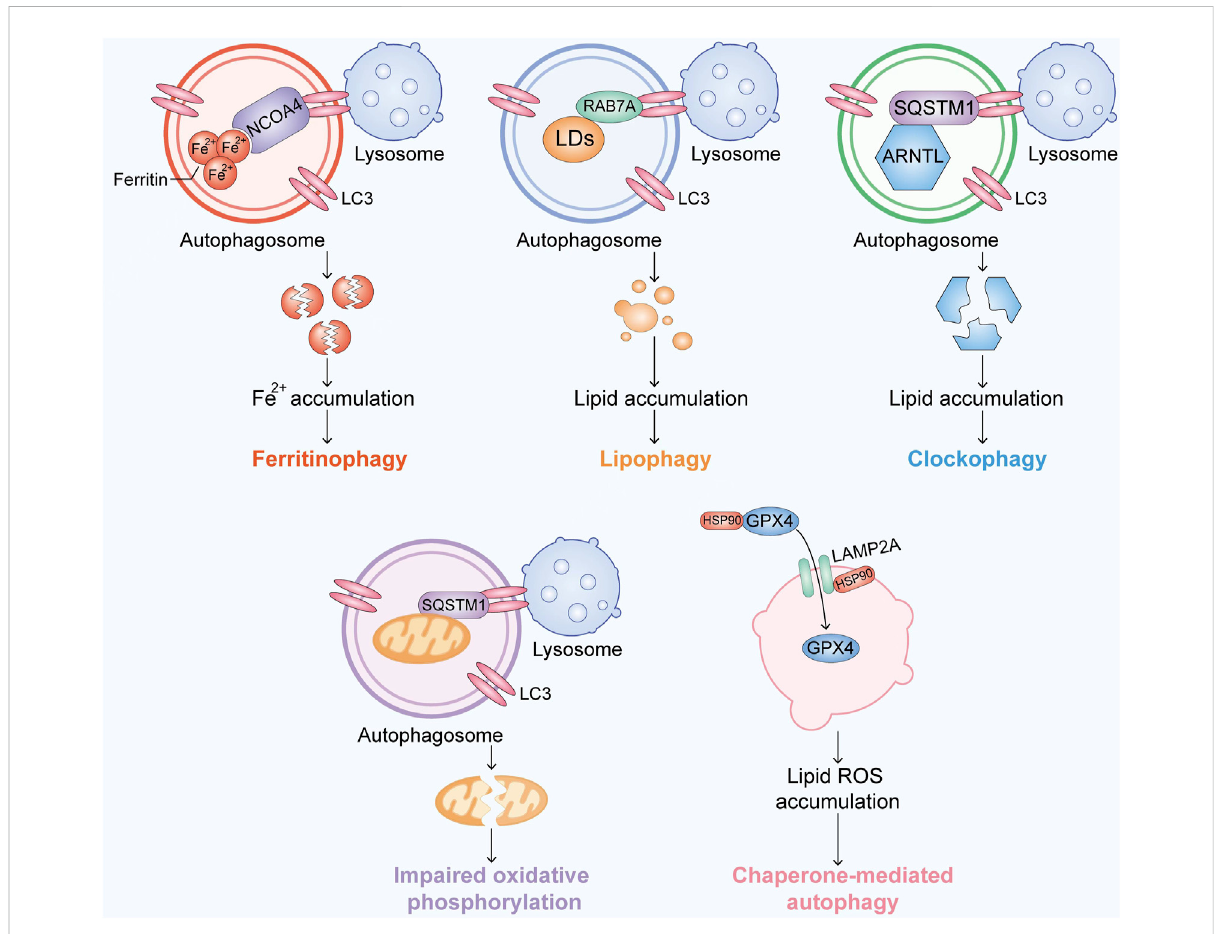
FIGURE 2 Overview of the recent research progress on autophagy-associated ferroptosis. Ferroptosis is activated by accumulating Fe, lipids or free radicals in an autophagic manner.